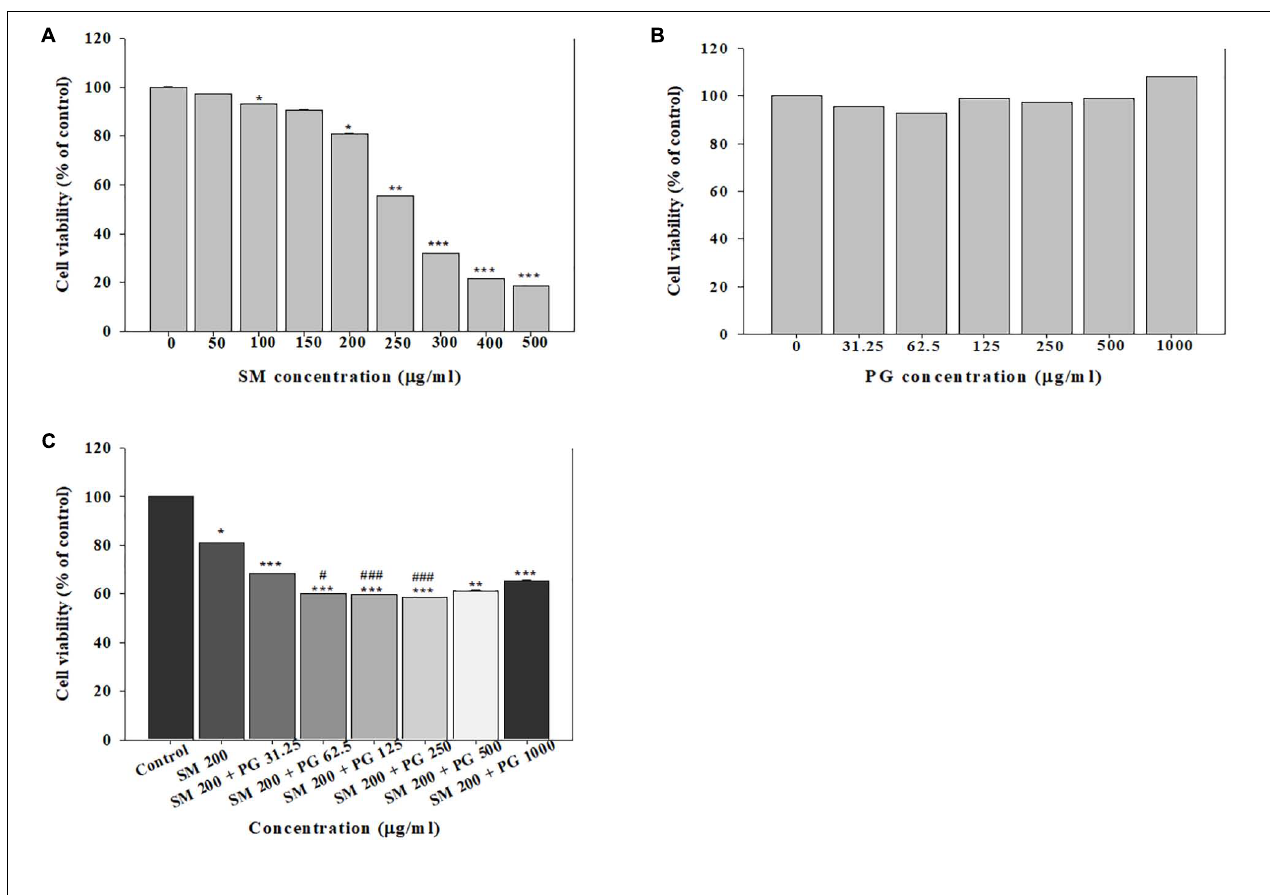
FIGURE 1 | The cell viability was measured by the MTT assay. The human lung epithelial cells (A549) were exposed to different concentrations of (A) sodium metabisulfite (SM), (B) propylene glycol (PG), and (C) a mixture of SM and PG for 24 h. The vales are reported as the mean ± SE (Student’s t -test, ∗ P < 0.05, ∗∗ P < 0.01, and ∗∗∗ P < 0.00 vs. control).